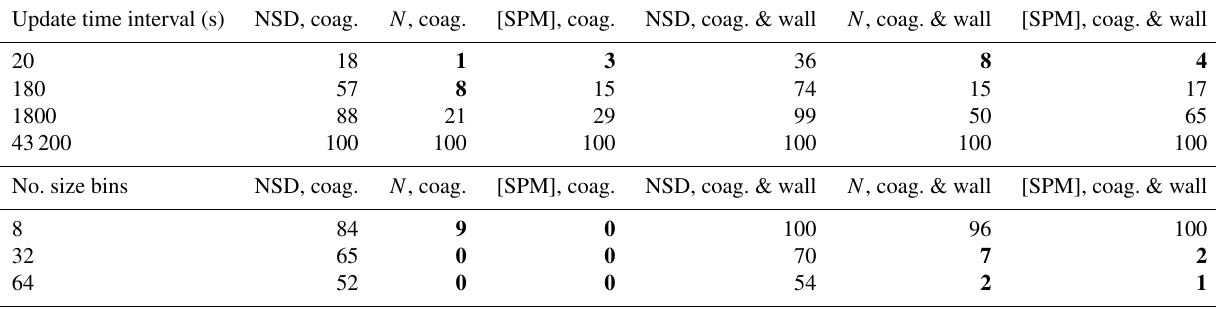
Table 4. Percent deviation from the high-resolution reference case for the nucleation with partitioning scenario. The particle properties given in column headings are defined in Table 3. An extremely low-volatility organic component was present at simulation start at 1ppb and set as the nucleating component in the absence of seed particles. In addition, 2-methylglyceric acid vapour was injected at a rate of 1 . 0 × 10 − 2 ppbs − 1 to grow particles through condensation.